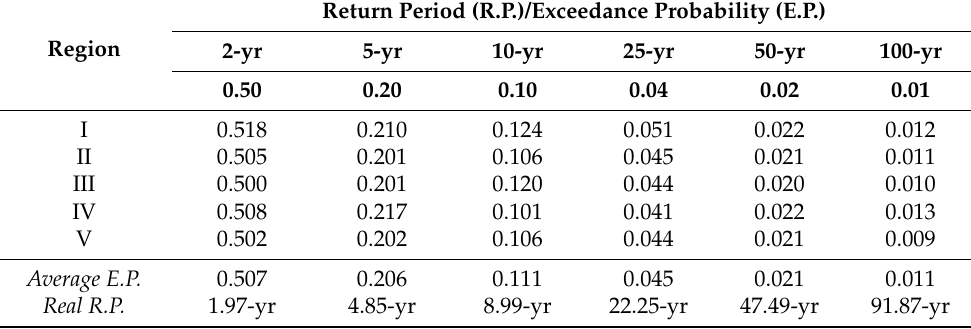
Table 3. Average exceedance frequencies for the study